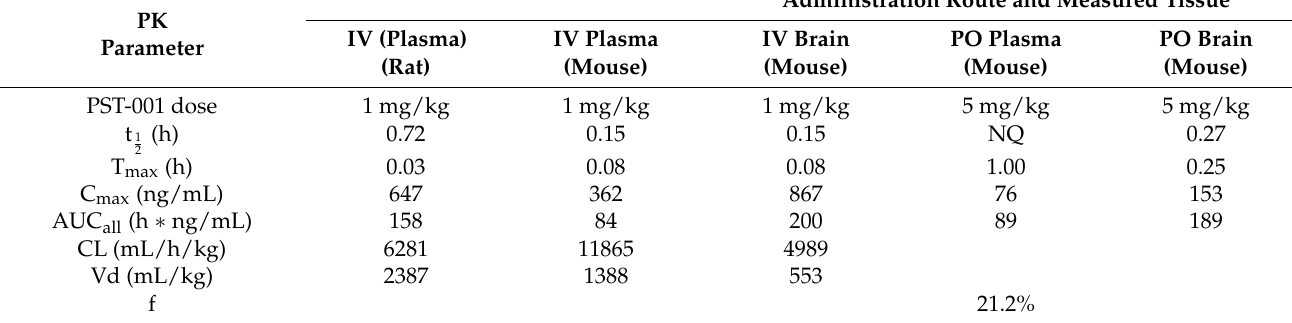
Table 2. In vitro pharmacokinetic (PK) assessment of PST-001 in rat (male Sprague Dowly) or mouse (male C57Bl) following IV or PO